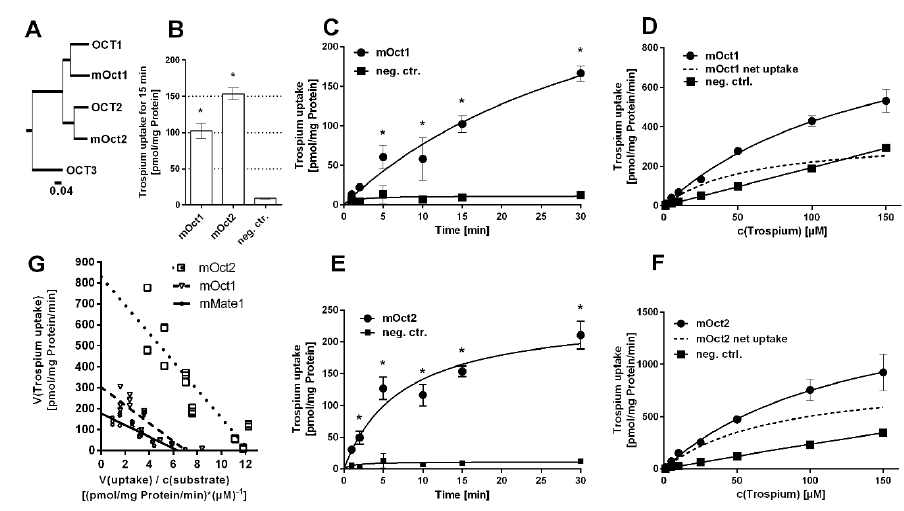
Figure 1. Trospium uptake by mOct1 and mOct2. ( A ) Phylogenetic tree of the human and mouse OCT/mOct carriers. The following GenBank accession numbers were used: NP_003048.1 for human OCT1, NP_003049.2 for human OCT2, NP_068812.1 for human OCT3, NP_033228.2 for mOct1, and NP_038695.1 for mOct2. Transport data represent means ± SD of representative experiments each with triplicate determinations. ( B ) Uptake of 1 µ M trospium was analyzed in HEK293 cells stably transfected with mOct1 or mOct2 as indicated and in non-transfected control cells (neg. ctr.) over 15 min. * Significantly different from negative control with p < 0.01 (one-way ANOVA). Time-dependent uptake of 1 µ M trospium over 1–30 min of substrate incubation via ( C ) mOct1 and ( E ) mOct2. * Significantly different from the respective time-point control with p < 0.01 (two-way ANOVA). Uptake at increasing trospium concentrations via ( D ) mOct1 and ( F ) mOct2. Non-transfected HEK293 cells served as control (neg. ctrl.). Carrier-specific uptake is indicated by dotted lines. Michaelis–Menten kinetic parameters were calculated from carrier-specific uptakes by nonlinear regression analysis. ( G ) Net uptake of trospium by mOct1 (Figure 1D), mOct2 (Figure 1F) and mMate1 (Figure 2D) were plotted as Eadie– Hofstee analysis. Intersection of regression lines with the y -axis indicates Vmax values; the slope indicates negative Km, and intersection with the x -axis indicates Vmax over